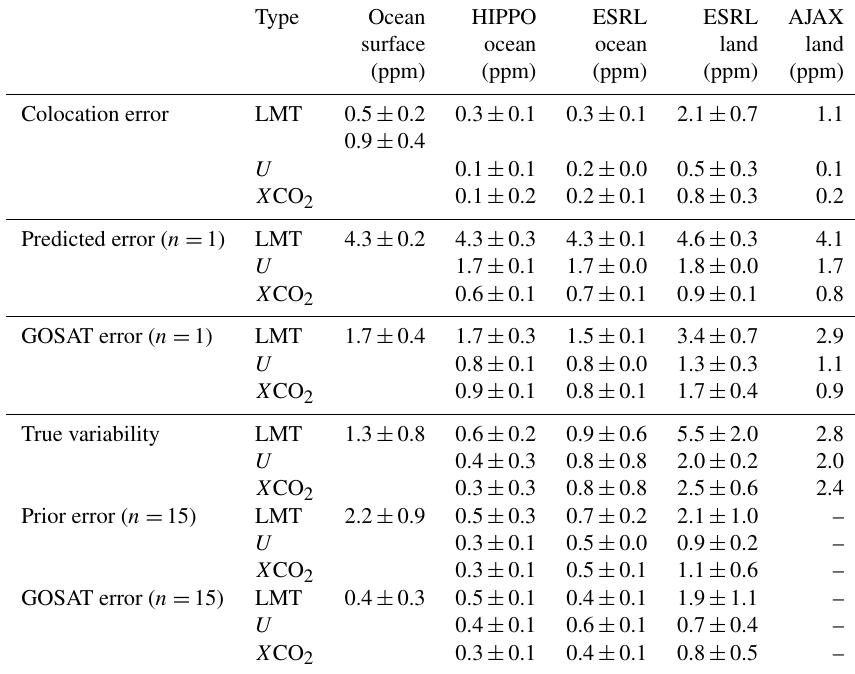
Table 5. Standard deviations versus validation data. See Table 3 for definitions of terms. The colocation errors have been subtracted out from the GOSAT errors.